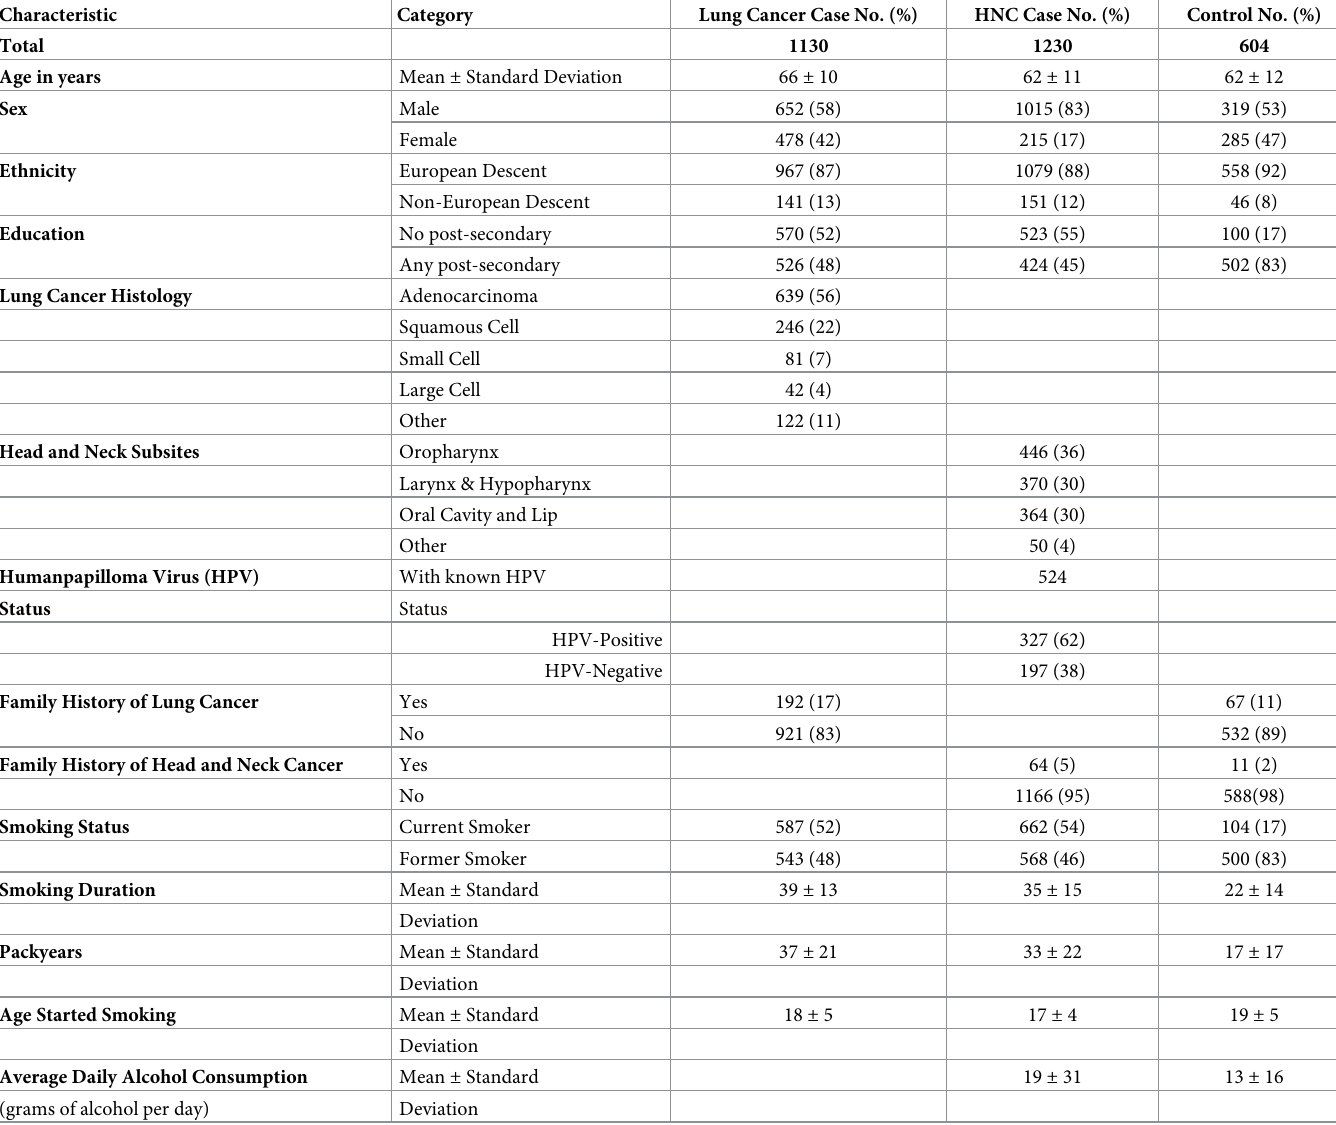
Table 1. Clinico-demographic characteristics of lung cancer cases, Head and Neck Cancer (HNC) cases and controls, among ever-smokers. Characteristic Category Lung Cancer Case No. (%) HNC Case No. (%) Control No. (%) 1130 1230